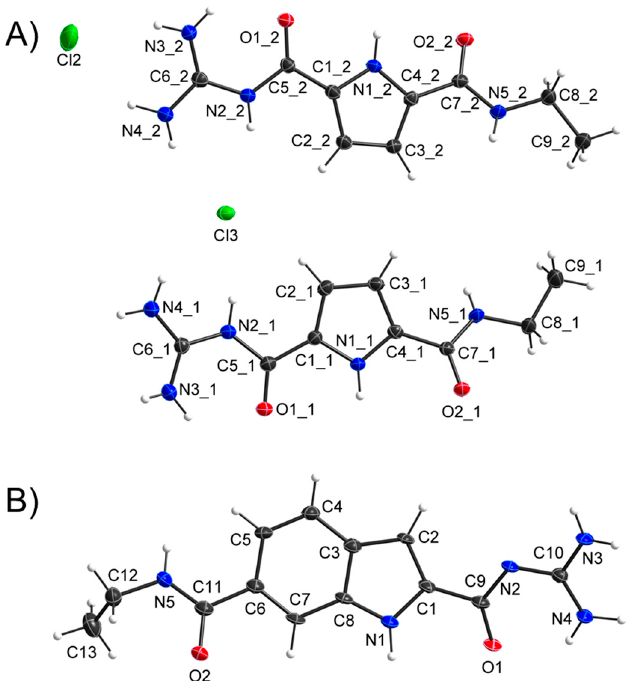
mM, pH = 6, concentration 10 µM, average of three independent measurements. [c] under the detection limit in the experiment. [d] measured in bis-tris buffer 6 mM, pH = 4, concentration 10 µM, average of three independent measurements. [e] measured in bis-tris buffer 6 mM, pH = 8, was determined using an concentration 10 µM, average of three independent measurements. Φ F integrated sphere. Figure 3. ( A ) X-ray diffraction analysis of GCP ethylamide ( 1 ) crystallised from methanol/water as cation. ( B ) X-ray diffraction analysis of GCI ethylamide ( 2 ) crystallised from water. Displacement ellipsoids are shown at 50% probability levels. Hydrogen atoms are displayed as spheres of arbitrary radius. Solvent molecules and counter-ions have been omitted for clarity (CCDC numbers: 2,150,514 and 2,150,515).